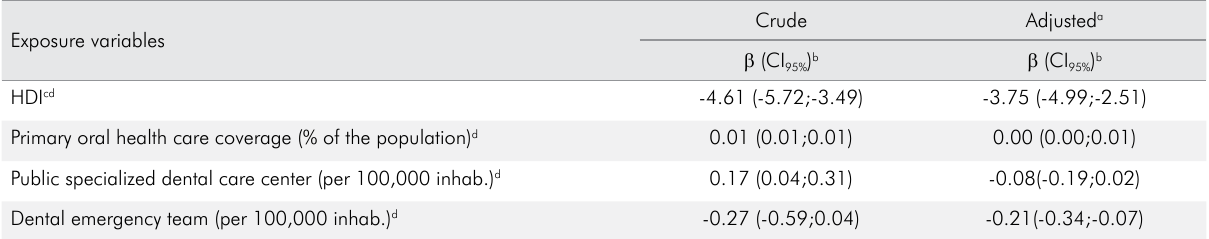
Table 5. Association between the proportion of dental visits in the year prior to the data collection due to toothache or tooth extraction and socioeconomic and dental services provision variables. National Health Survey (PNS), 2019.